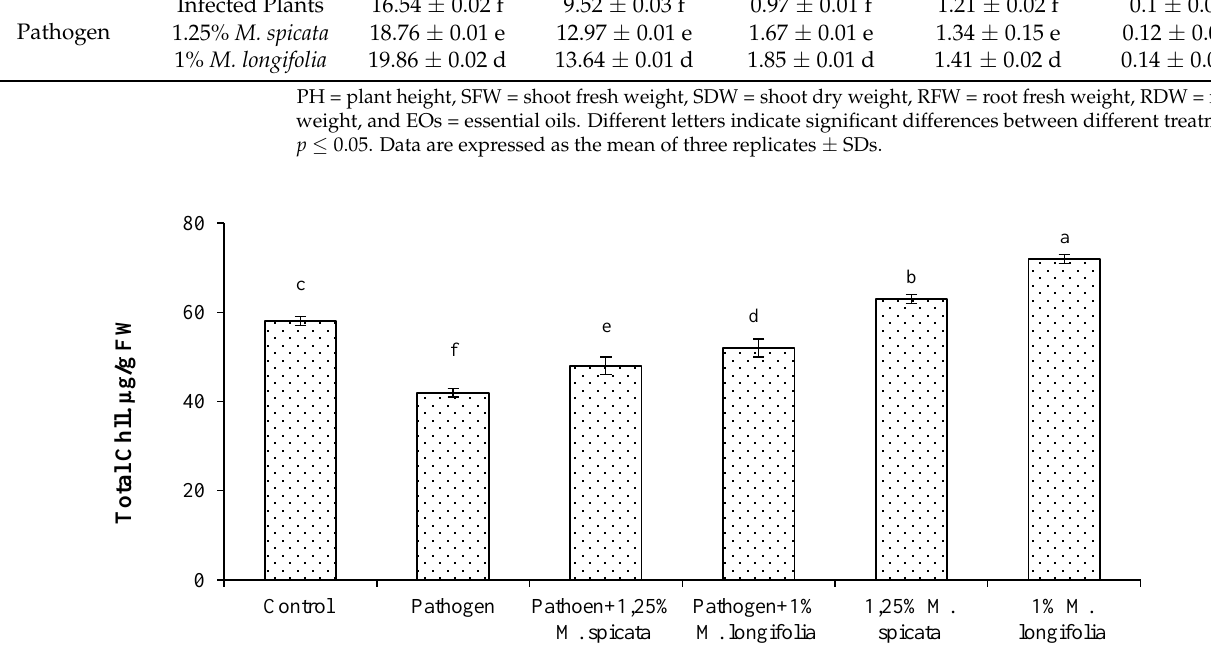
Figure 5. Effects of highest concentrations of M. spicata and M. longifolia EOs on total chlorophyll content (Chll) in L. esculentum seedling under Fusarium root rot disease infection. Bars with different letters indicate significant differences between treatments at p ≤ 0.05. Data are expressed as the mean of three replicates ± SDs.